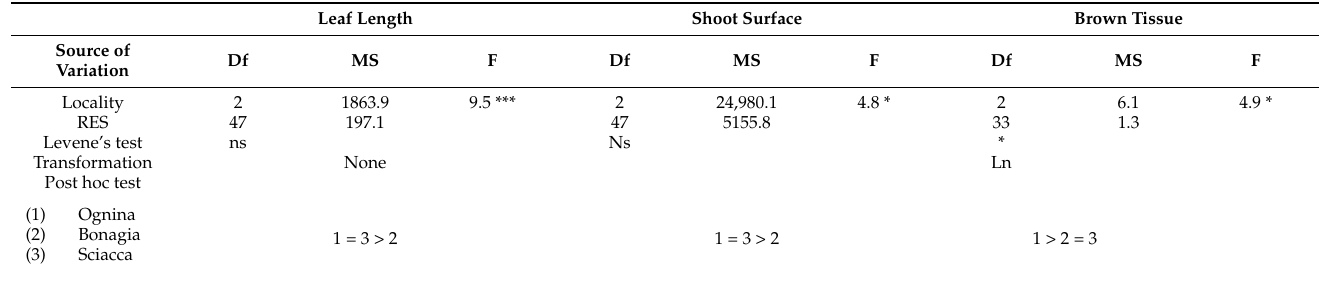
Table 5. ANOVA results on leaf length, shoot surface, and brown tissue. Leaf Length Shoot Surface Brown